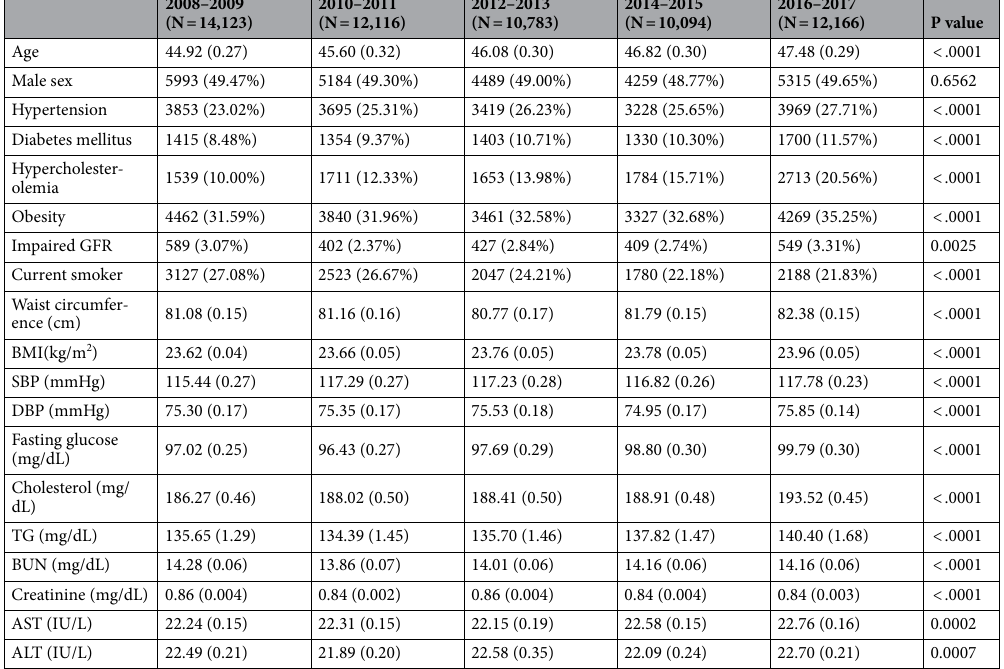
Table 1. Clinical and laboratory characteristics of KNHANES participants. Data are presented as number (weighted %) or weighted mean (SE). GFR glomerular filtration rate, BMI body mass index, SBP systolic blood pressure, DBP diastolic blood pressure, TG triglyceride, BUN blood urea nitrogen, AST aspartate aminotransferase, ALT alanine aminotransferase. P values are calculated by one-way ANOVA for continuous variables and by Rao-Scott χ 2 for discrete variables.